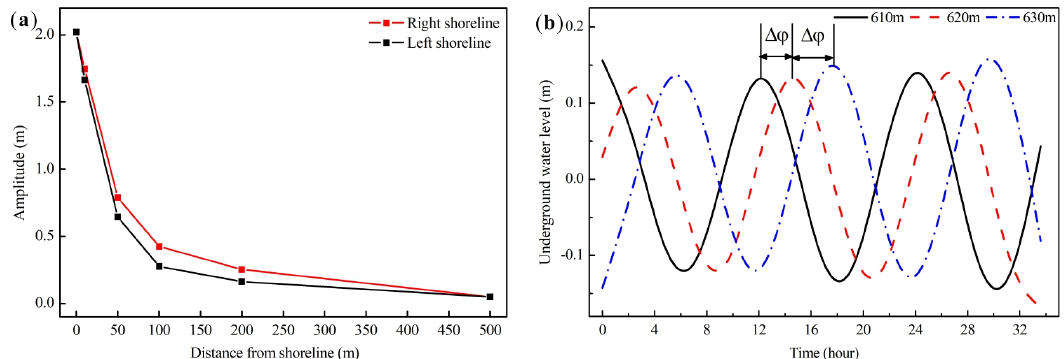
Figure 7. The amplitude attenuation and phase lag of the groundwater table in the un-excavated condition: ( a ) the fluctuation amplitude; ( b ) the fluctuation phase, Δ φ phase difference.